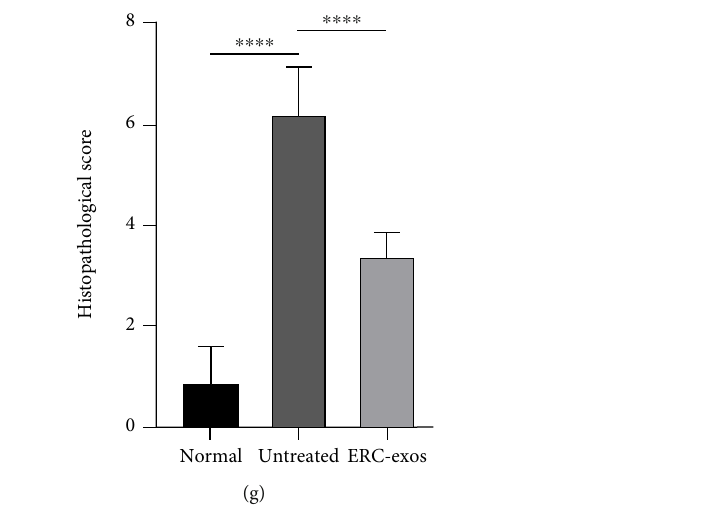
Figure 4: ERC-exos attenuated experimental colitis in mice. (a) Body weight changes of mice from each group. (b) Representative pictures showing bloody stool indi ff erent groups. (c) DAI score was used to assess the colitis activity. (d, e) The length of colons was measured and analyzed. (f) Representative images of colon tissues in each group (H&E staining). (g) Histopathology scores were evaluated and calculated. The p value was determined by one-way ANOVA. ∗ p < 0 : 05 , ∗∗ p < 0 : 01 , ∗∗∗ p < 0 : 001 , and ∗∗∗∗ p < 0 : 0001